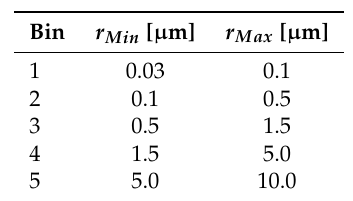
Table 5. Minimum and maximum radius of the five size bins that describe the dry sea salt size distribution.